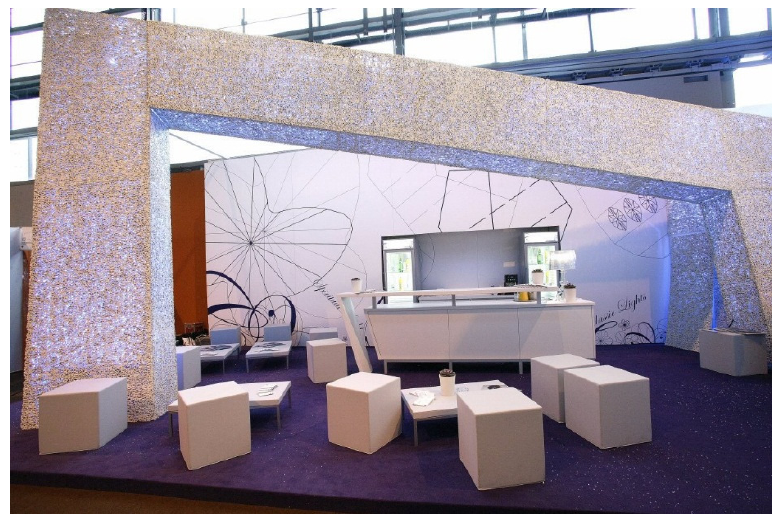
Figure 18. Booth for the convention center with an Alusion foam structure (courtesy of Alusion).